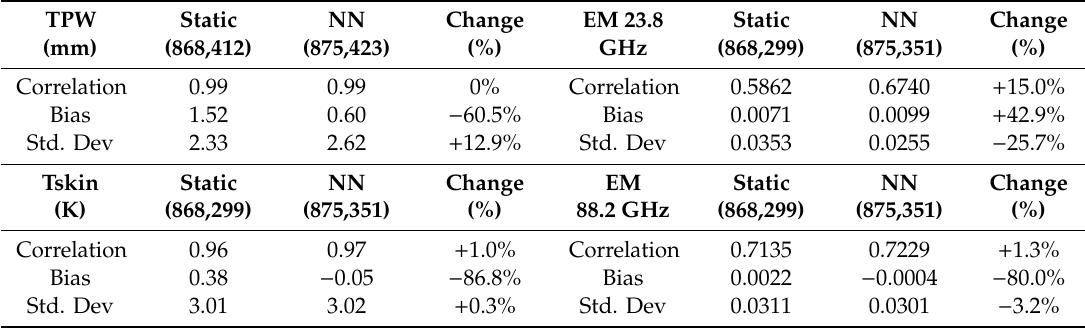
Table 3. Performance metrics of MiRS retrievals including TPW, Tskin, emissivity (EM) at 23.8 GHz and 88.2 GHz, validated using ECMWF analyses (and FASTEM5 for emissivity) for SNPP /